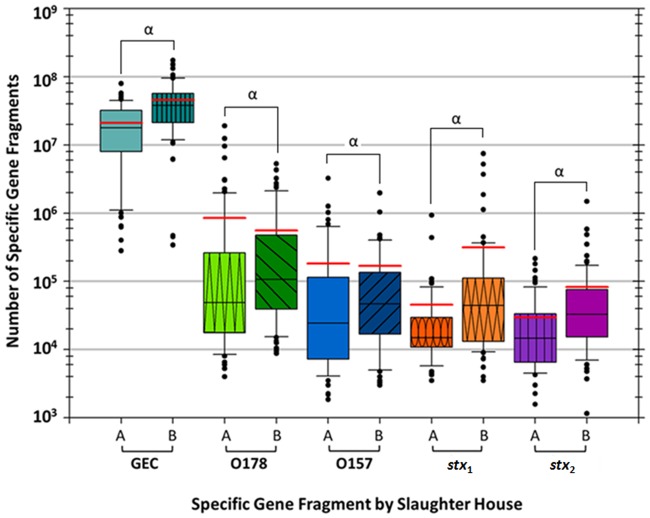
Total number of generic E. coli (GEC), O178, O157, shiga toxin (stx) 1 and 2 specific gene fragments in samples from slaughterhouse A or B (calculated using droplet digital PCR).In each comparison between slaughterhouse A and B there were significant differences in enumeration of gene fragments, denoted by symbol α. Note: *The red line is the average number of GEC, O178, O157, stx1 and stx2 at each slaughterhouse and the black line in the boxes is the median.